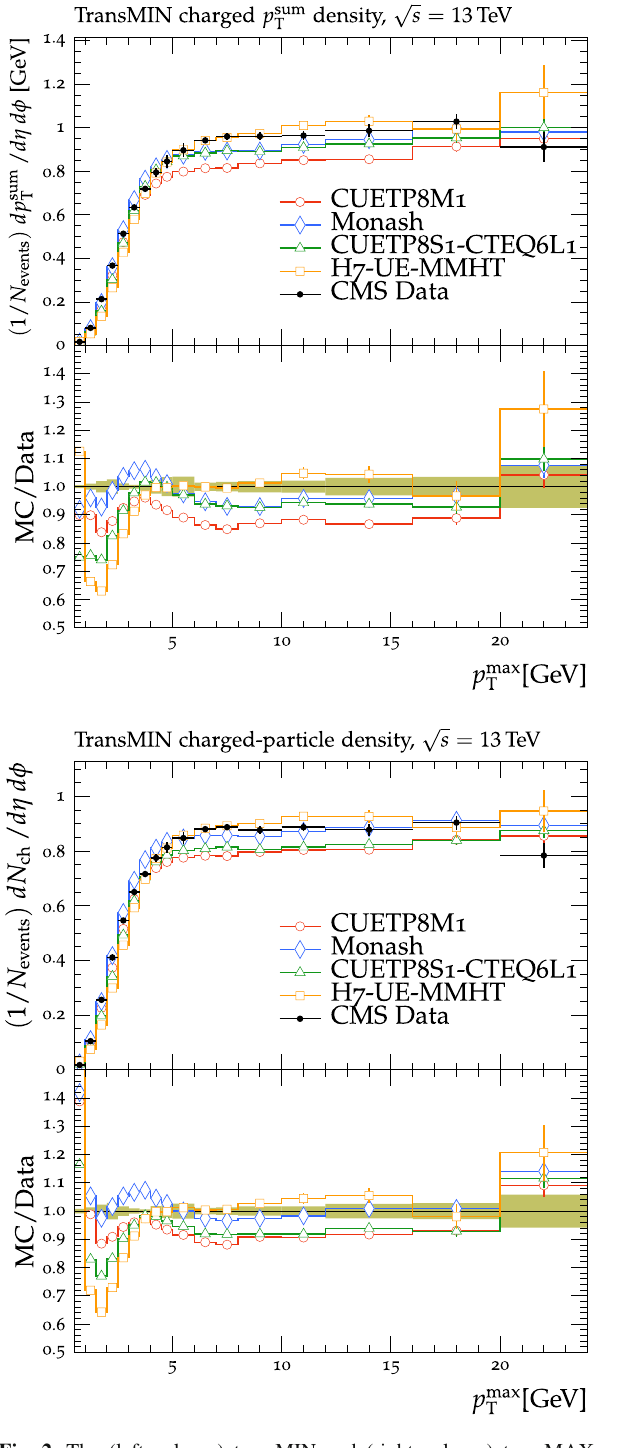
Fig. 2 The (left column) transMIN and (right column) transMAX The ratios of the simulations to the data (MC/Data) are also shown, where the shaded band indicates the total experimental uncertainty in charged-particle p sum (upper row), and multiplicity (lower row) den- T the data. Vertical lines drawn on the data points refer to the total uncer- sities for particles with p T > 0 . 5GeV in | η | < 2 . 0, as a function of tainty in the data. Vertical lines drawn on the MC points refer to the the transverse momentum of the leading charged particle ( p max ), from √ T s = 13TeV analysis [16]. The data are compared with the statistical uncertainty in the predictions. Horizontal bars indicate the the CMS pythia 8 tune Monash, the CMS pythia 8 tunes CUETP8S1-CTEQ6L1 associated bin andCUETP8M1,andthe herwig 7(labelledas“H7”)tuneUE-MMHT.